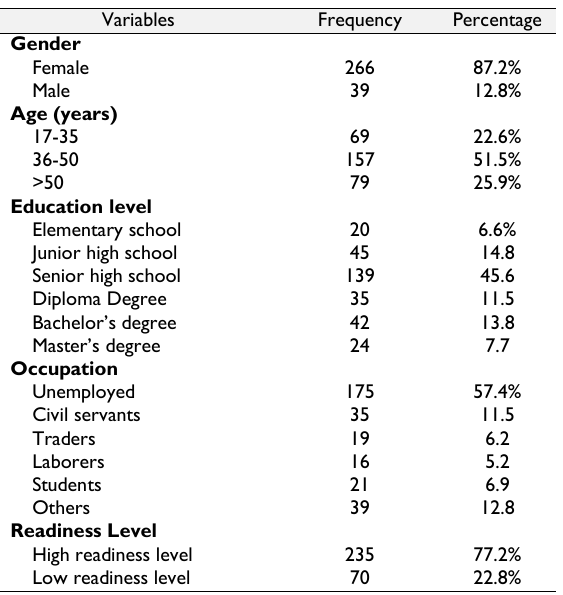
Table 1 Demographic characteristics and readiness level of the respondents (n =